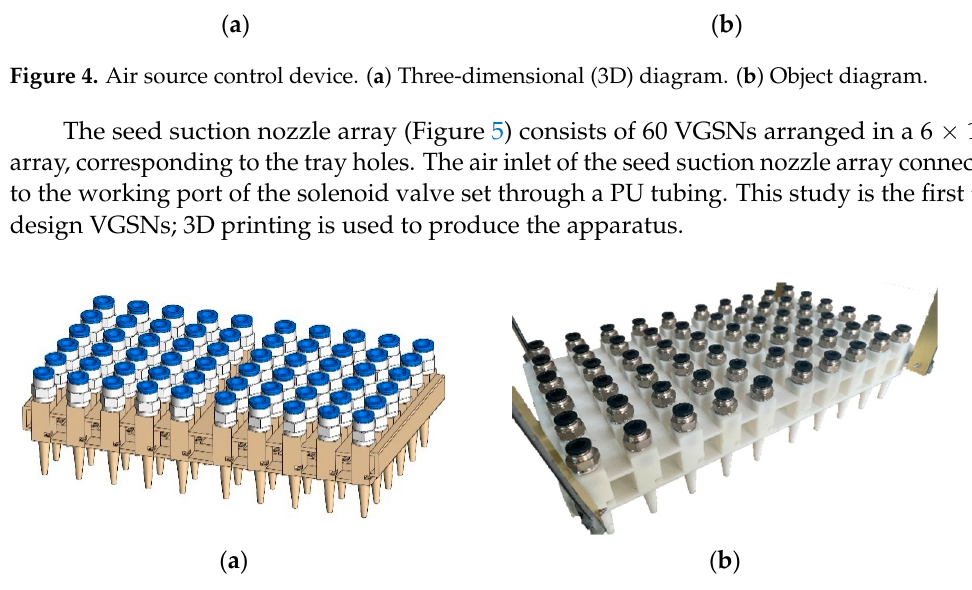
Figure 5. Seed suction nozzle array; ( a ) 3D diagram; ( b ) Object diagram.